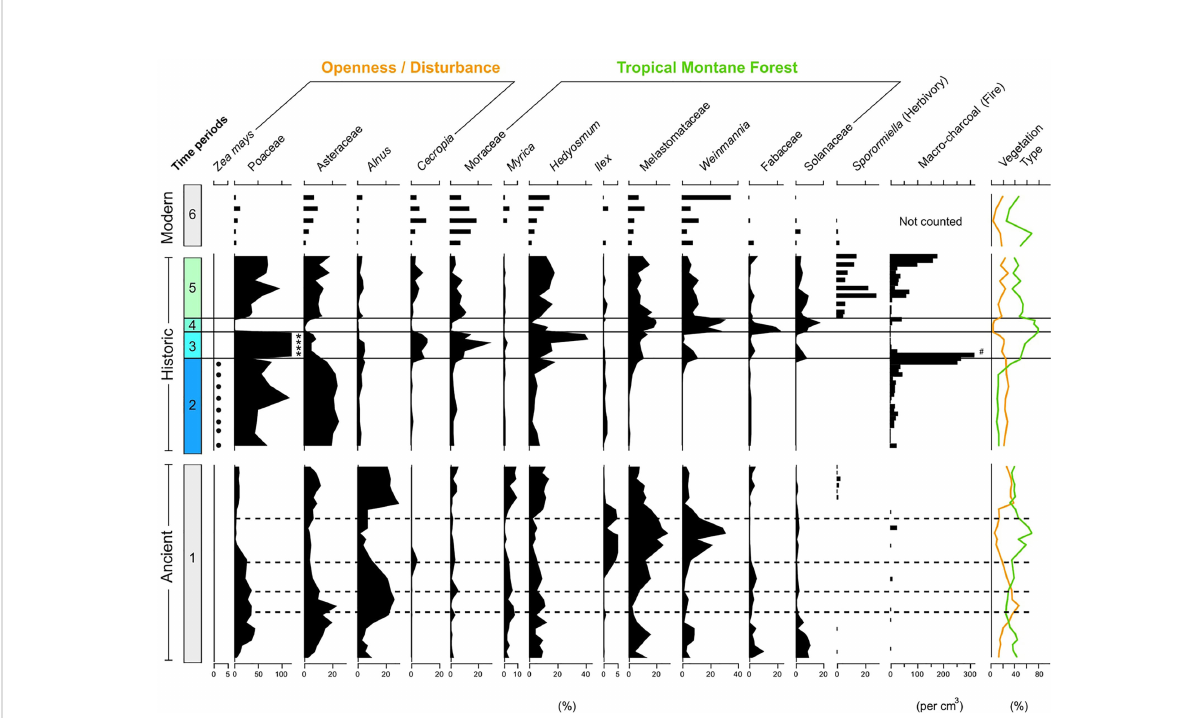
FIGURE 2 Synthetic summary diagram of selected pollen types grouped into time bins. 1) Ancient (pre-human arrival), 2) Pre-European (Indigenous cultivation), 3) Successional (European arrival/Indigenous depopulation), 4) Mature (diminished population), 5) Deforestation (re-colonisation), and 6) Modern (industrial agriculture). Sporormiella fungal spores and macro-charcoal included as proxies of herbivory and fi re respectively. Dashed lines in the ‘ Ancient ’ (1) time bin represent the position of volcanic tephra layers within the sediment. Due to the abundance of Poaceae (grass) pollen in the ‘ Historic ’ record grass pollen was excluded from the pollen sum. Asterisks (*) in the ‘ Historic ’ (3) time bin represent where Poaceae pollen exceeded 100% of the pollen sum. Zea mays presence recorded as dots (.) The ‘ Modern ’ records are displayed as bars as they are distinct geographic sites ( see Figure 1). Hash (#) indicates where macro-charcoal exceeds 300 fragments per cm 3